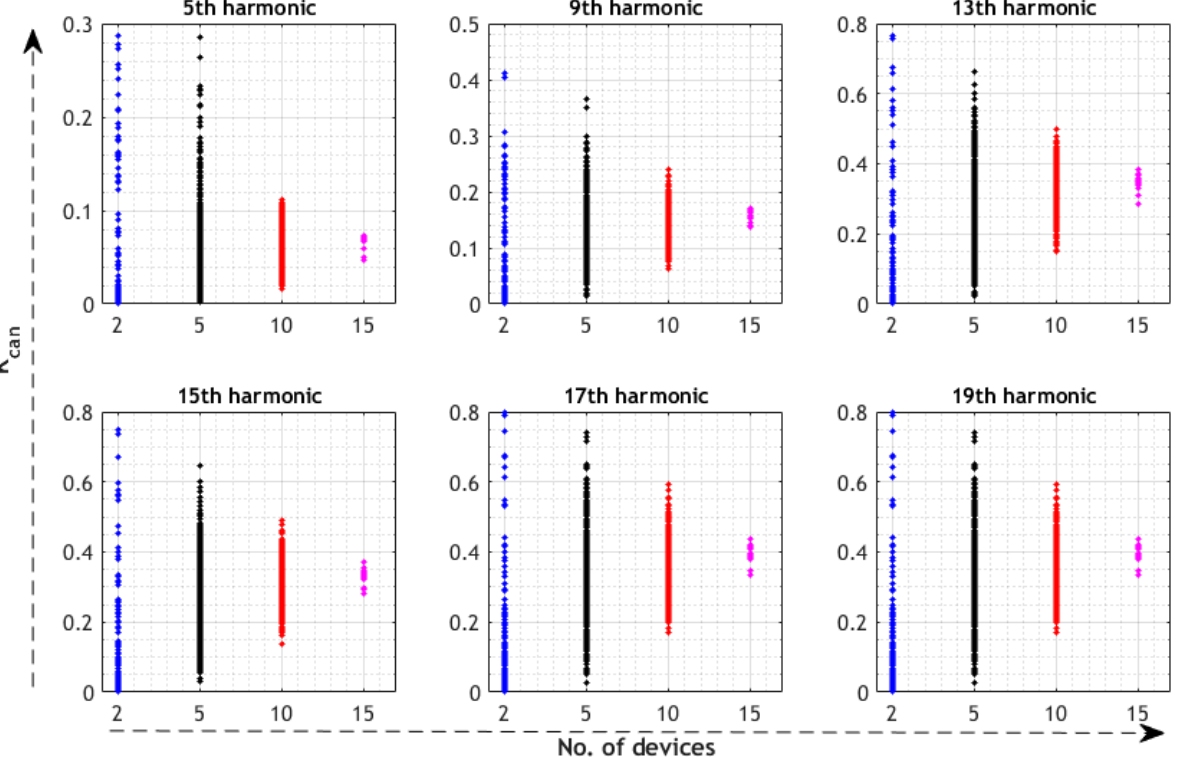
Figure 9. Harmonic cancellation coefficient of LED load devices operating at the same time.